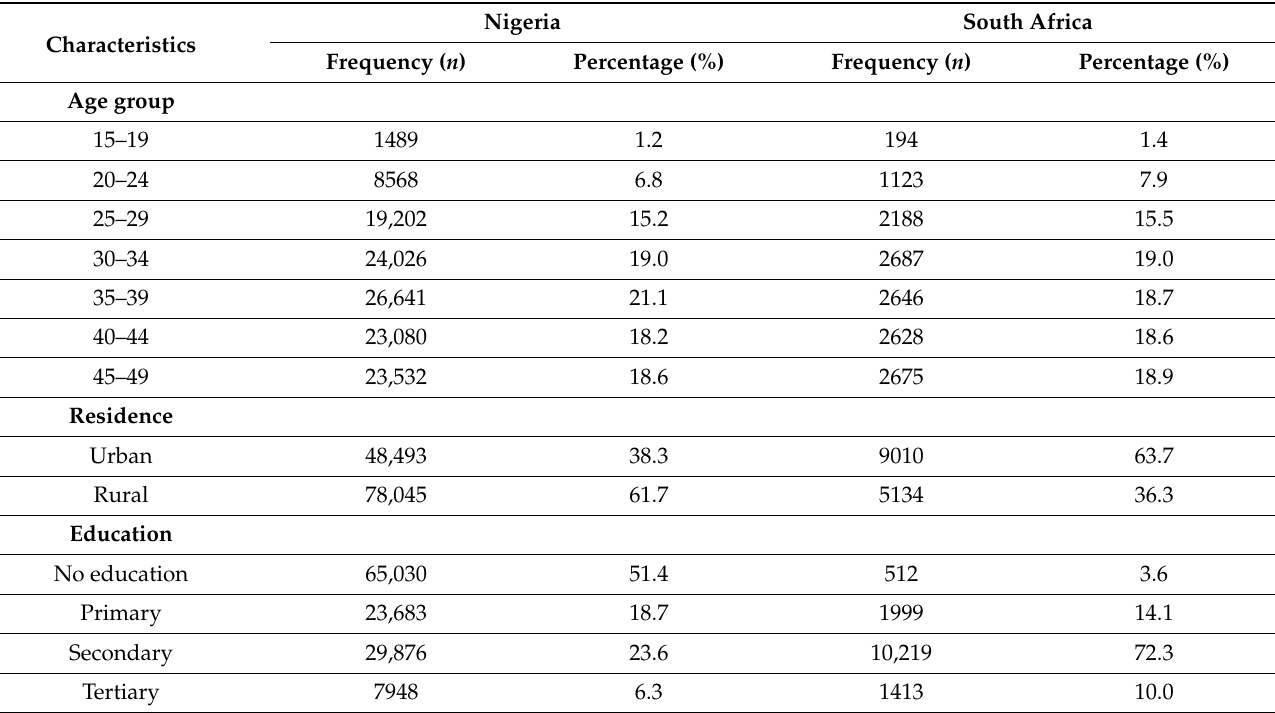
Table 2. Socio-demographic, geographical, and behavioral characteristics of women in Nigeria and South